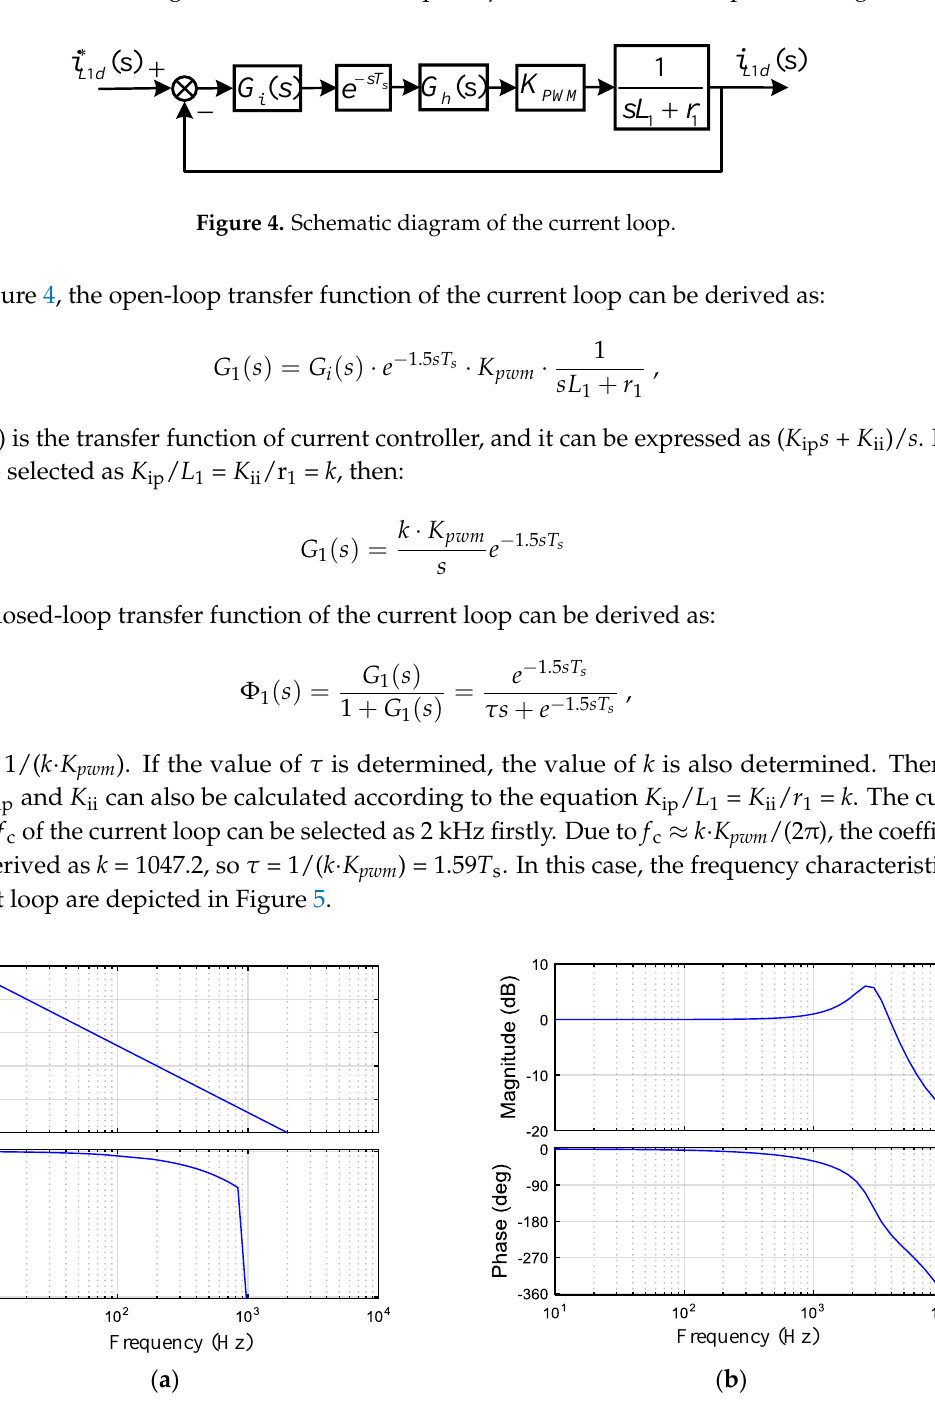
Figure 5. Bode diagrams of the current loop with discrete control when τ = 1.59 T s : ( a ) Open-loop Bode diagrams; ( b ) Close-loop Bode diagrams.